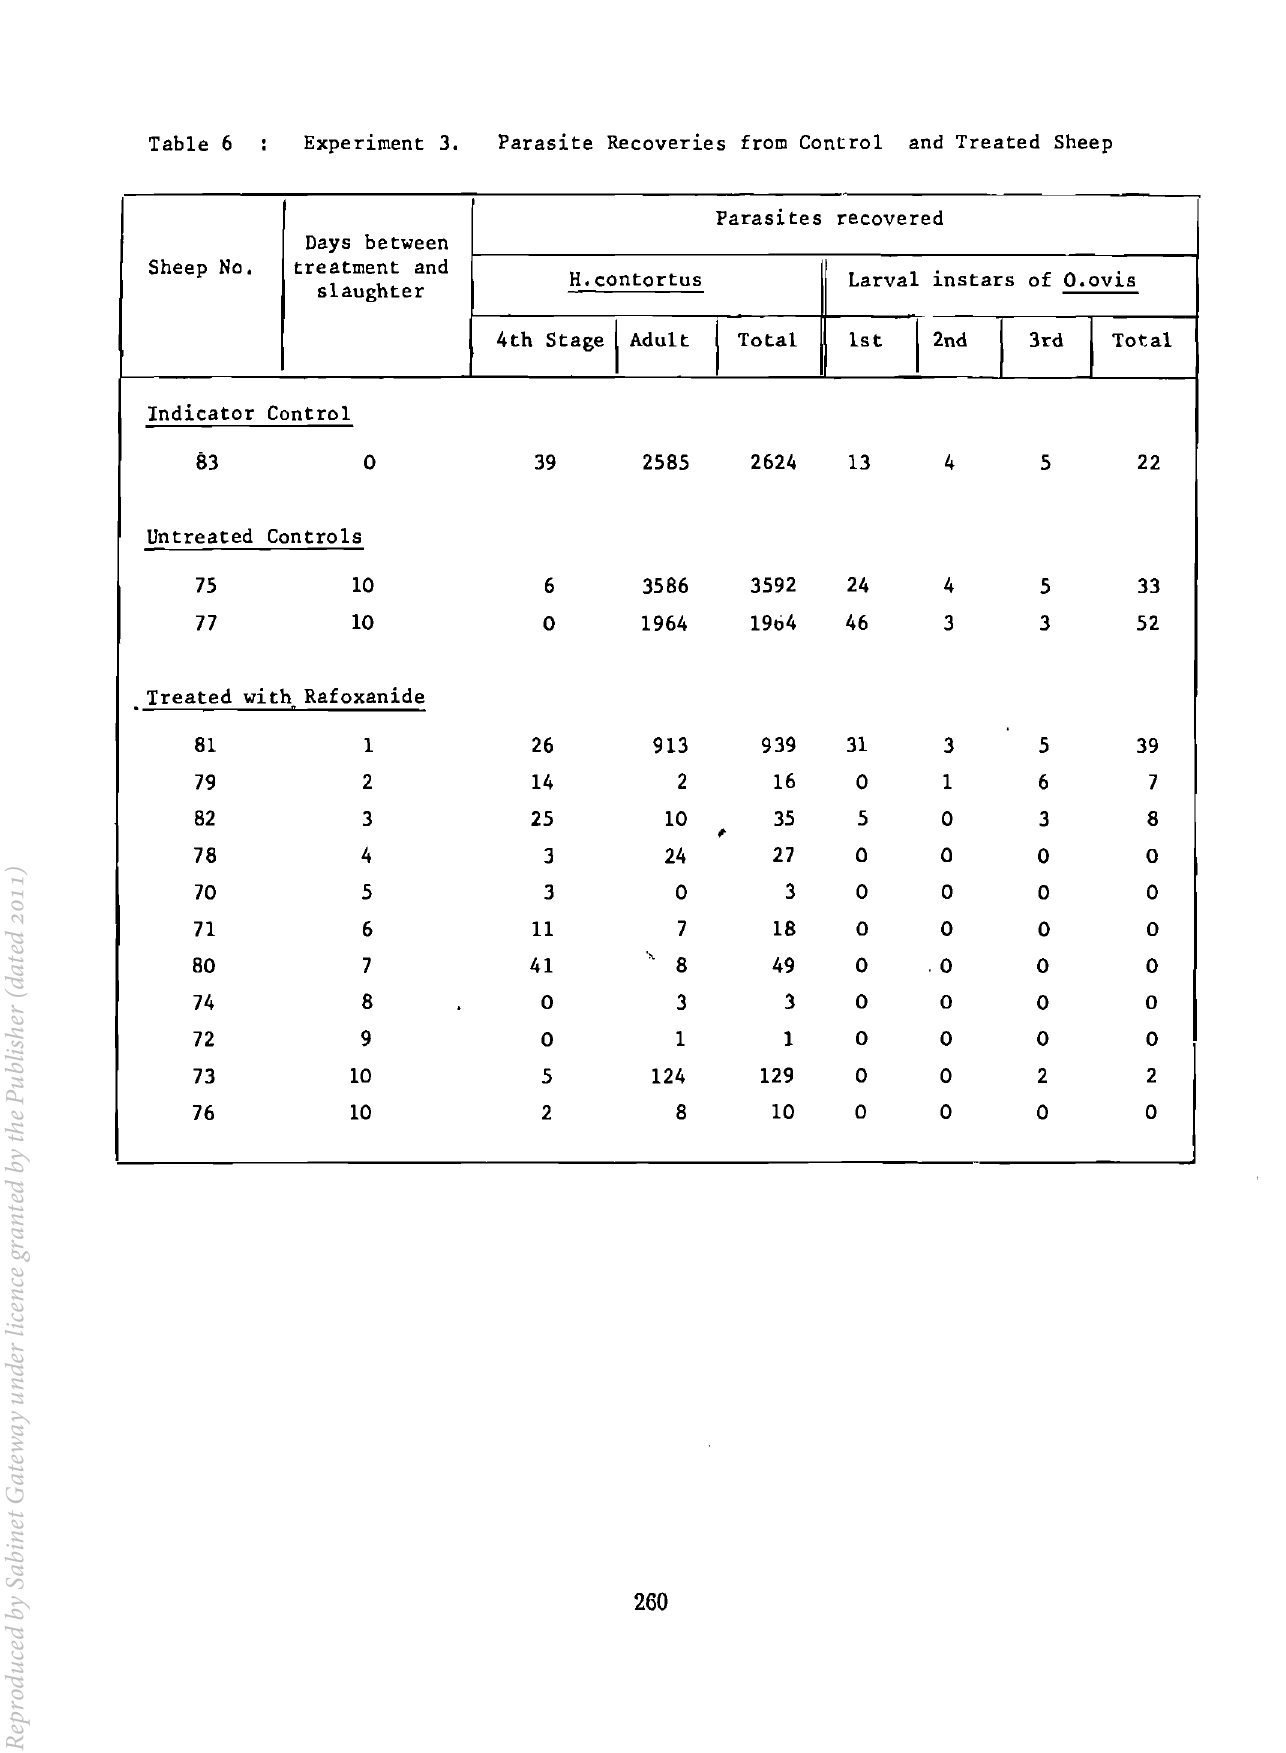
Table 6 Experiment 3. Parasite Recoveries from Control and Treated Sheep